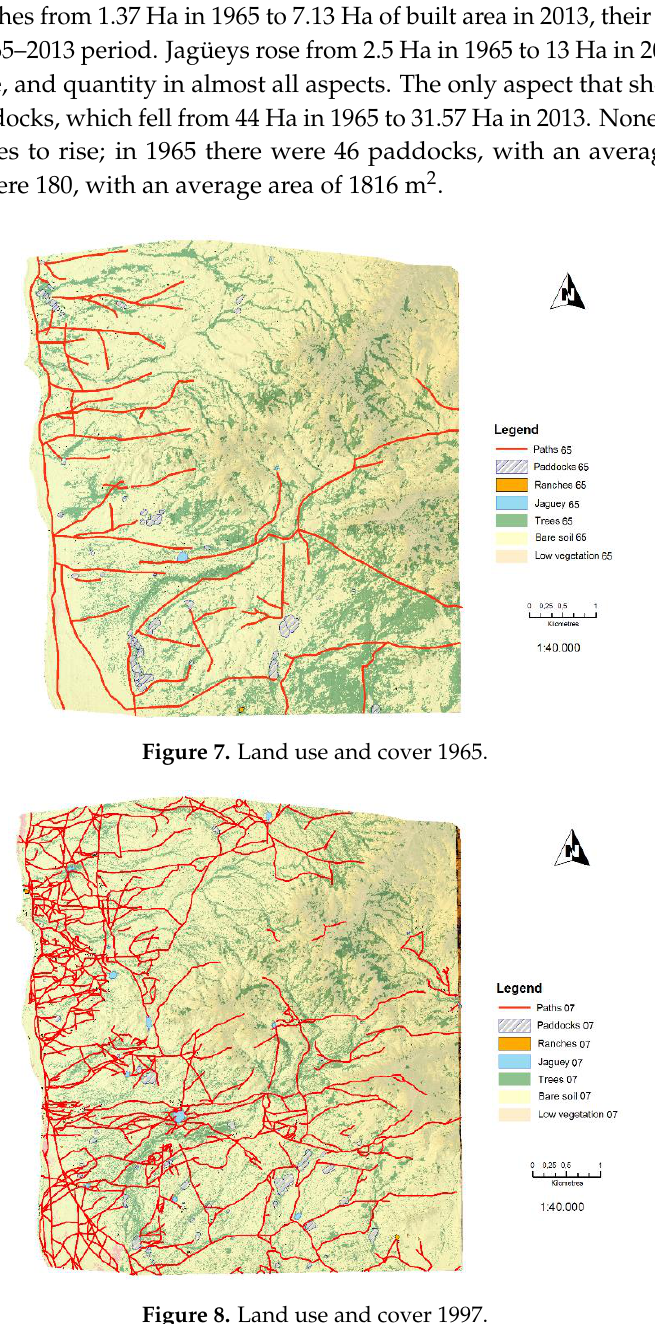
Figure 8. Land use and cover 1997.